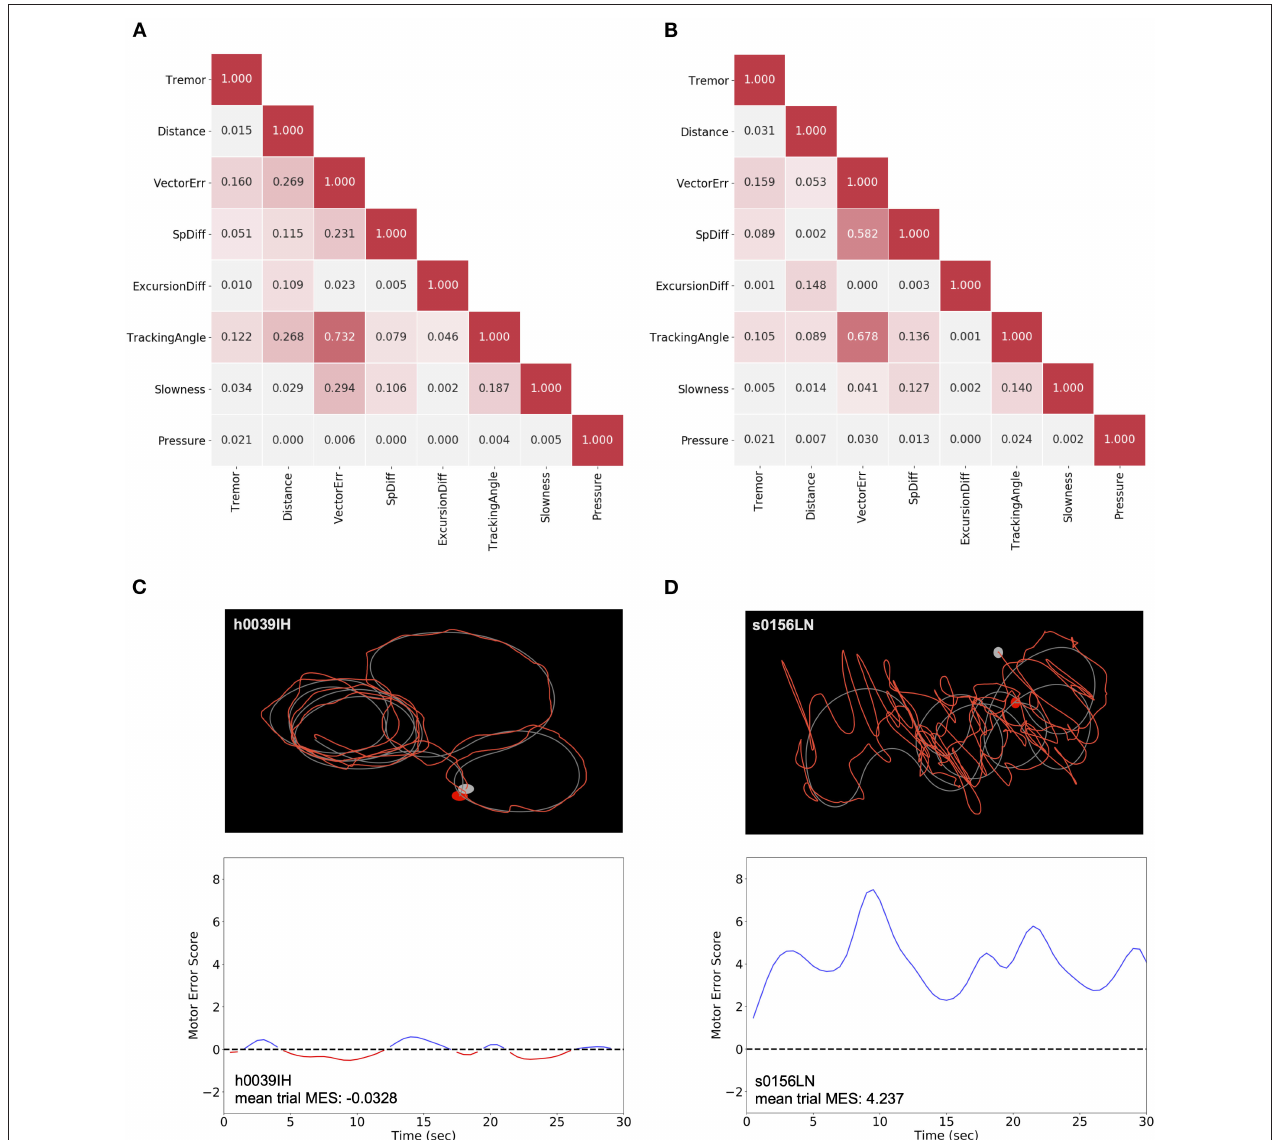
FIGURE 1 | Generation of MES using non-redundant metrics. (A,B) For each subject, the distribution for each metric was normalized to the pooled control subject data for that metric. The strength of the association was compared between each pair of normalized metric means across all control subjects (A) and patients with PD (B) . Pearson’s r 2 are shown to indicate the strength of correlation. (C,D) The raw trace data from individual trials (top) of control subjects like h0039IH (C) and patients with PD, like s0156LN (D) were used to calculate the eight metrics. These metrics were then used to generate an SVM classifier model by comparing a single subject to a sampling of pooled control subject data. The distance from each point of patient data to the hyperplane for a given epoch corresponds to the MES, which serves as an aggregate, scalar measure of motor dysfunction across a representative trial (bottom). Here, a Gaussian smoothing function was applied to the MES for visualization